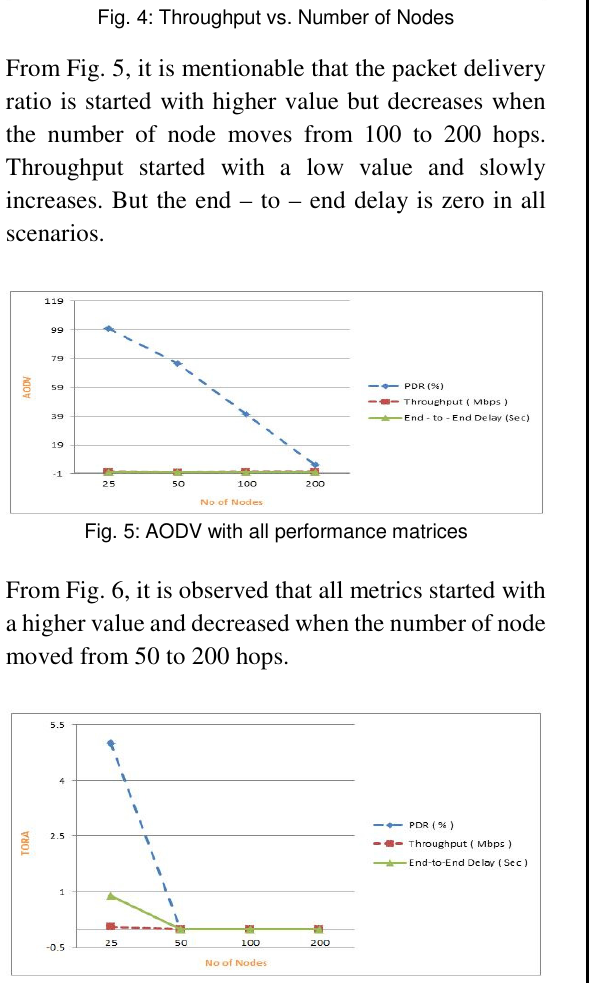
Fig. 6: TORA with all performance matrices